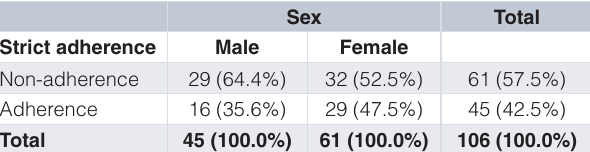
Table 10. Univariate analysis of sex and strict adherence (all categories), Pearson χ 2 = 1.5, P = 0.217 (Fishers exact P = 0.239).